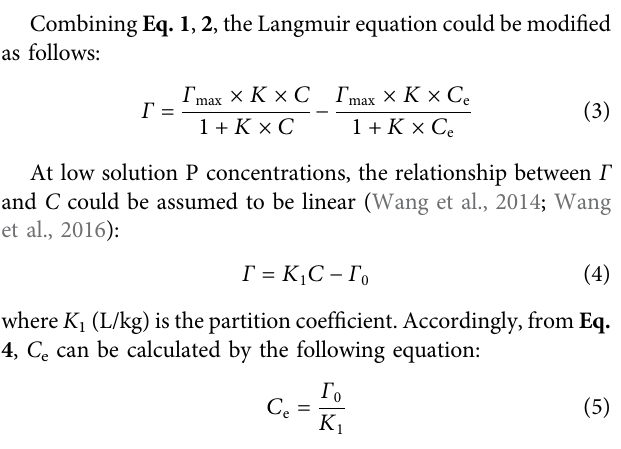
TABLE 1 | Selected properties of soils and organic materials used in the study ( n = 3 ). Treatments